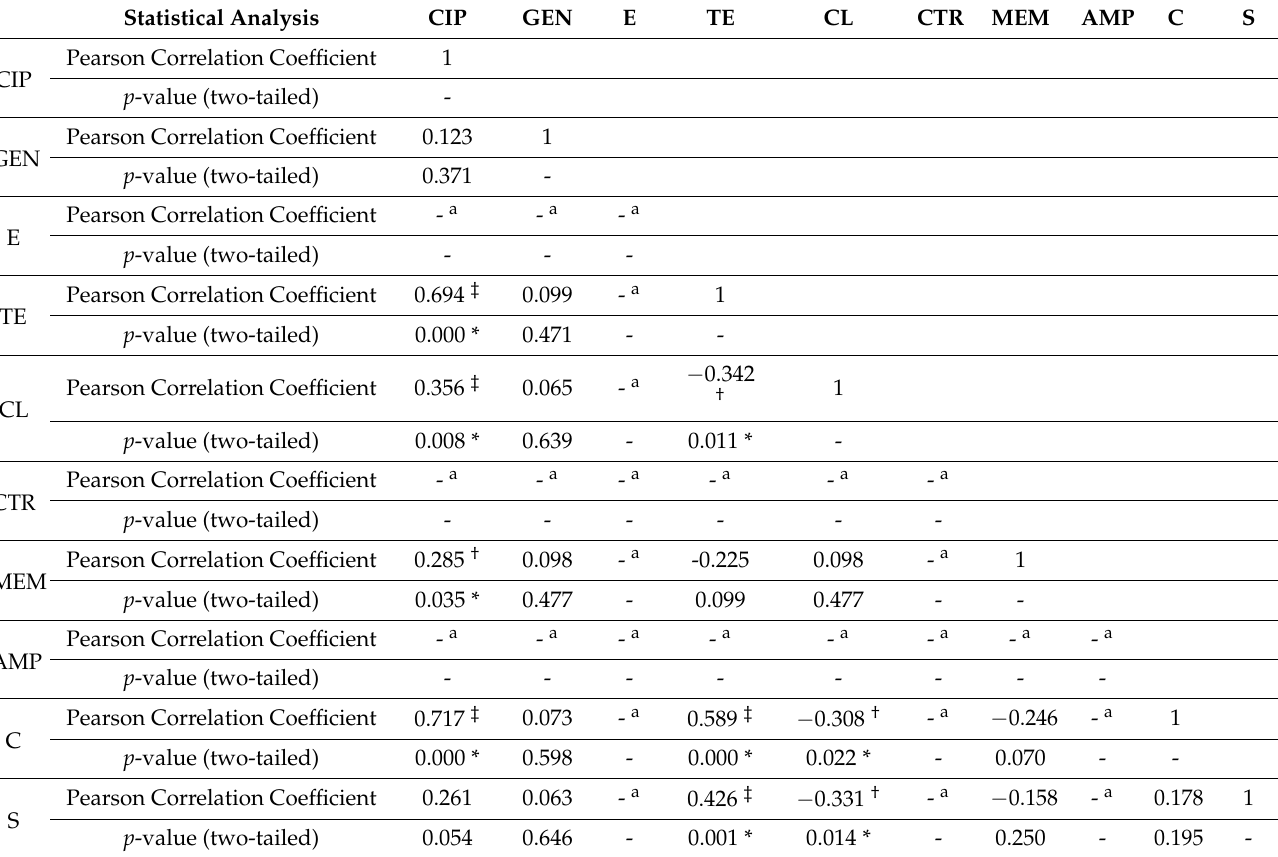
Table 3. Pearson correlation coefficients for pairs of antibiotics to assess antibiotic-resistant E. coli isolates from fecal samples of migratory